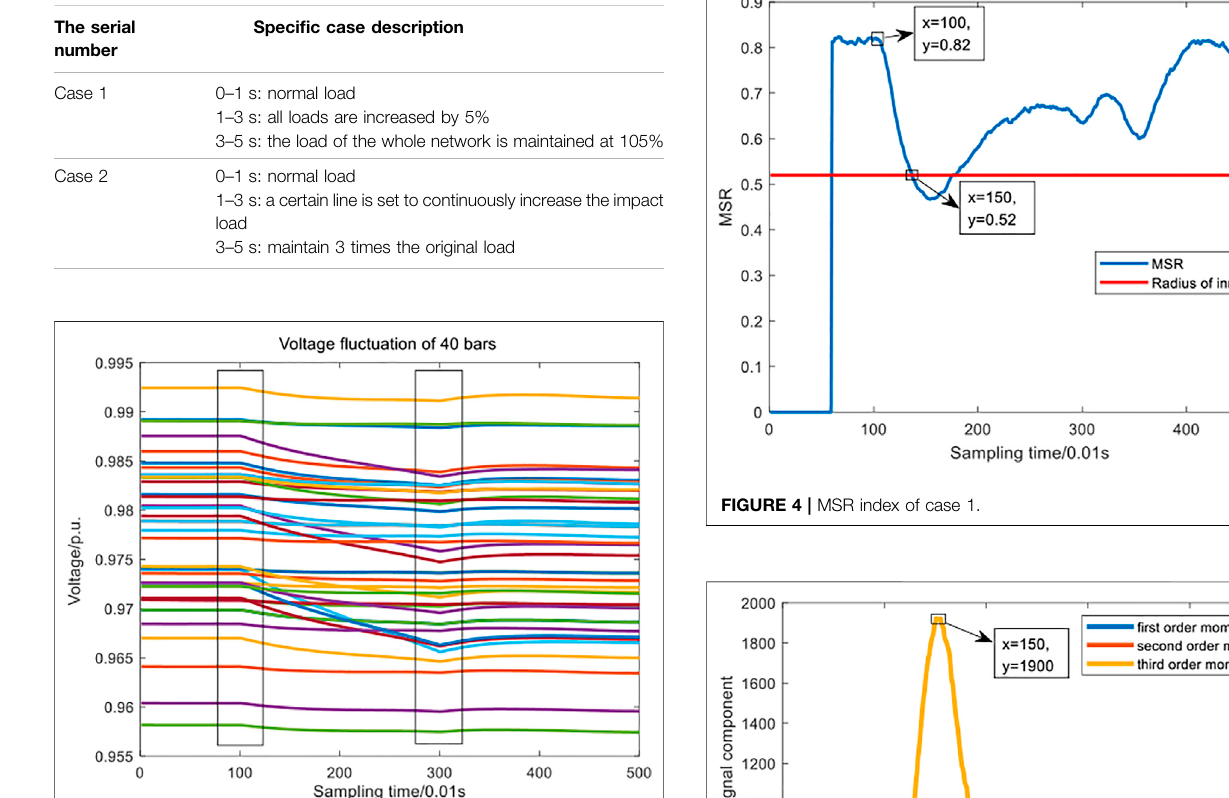
FIGURE 2 | Original voltage data of 40 buses in case 1.